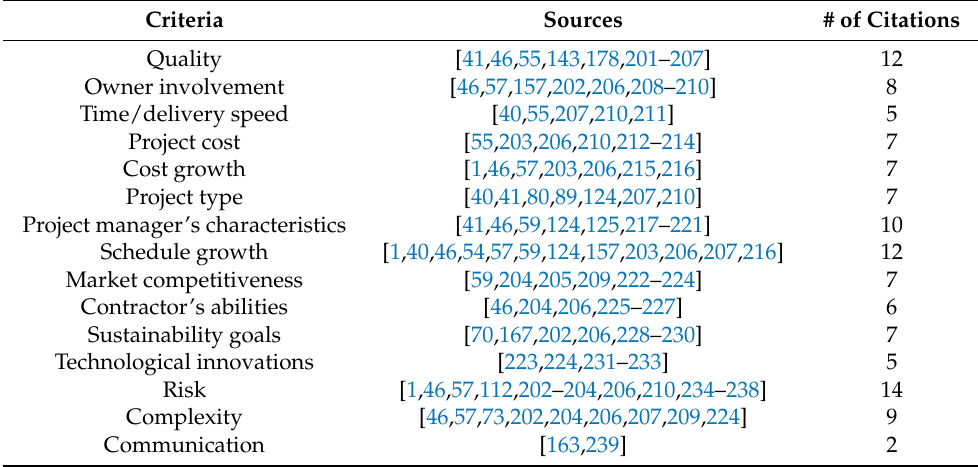
Figure 6. Evolution of selection criteria. Table 2. Overview of selection criteria.